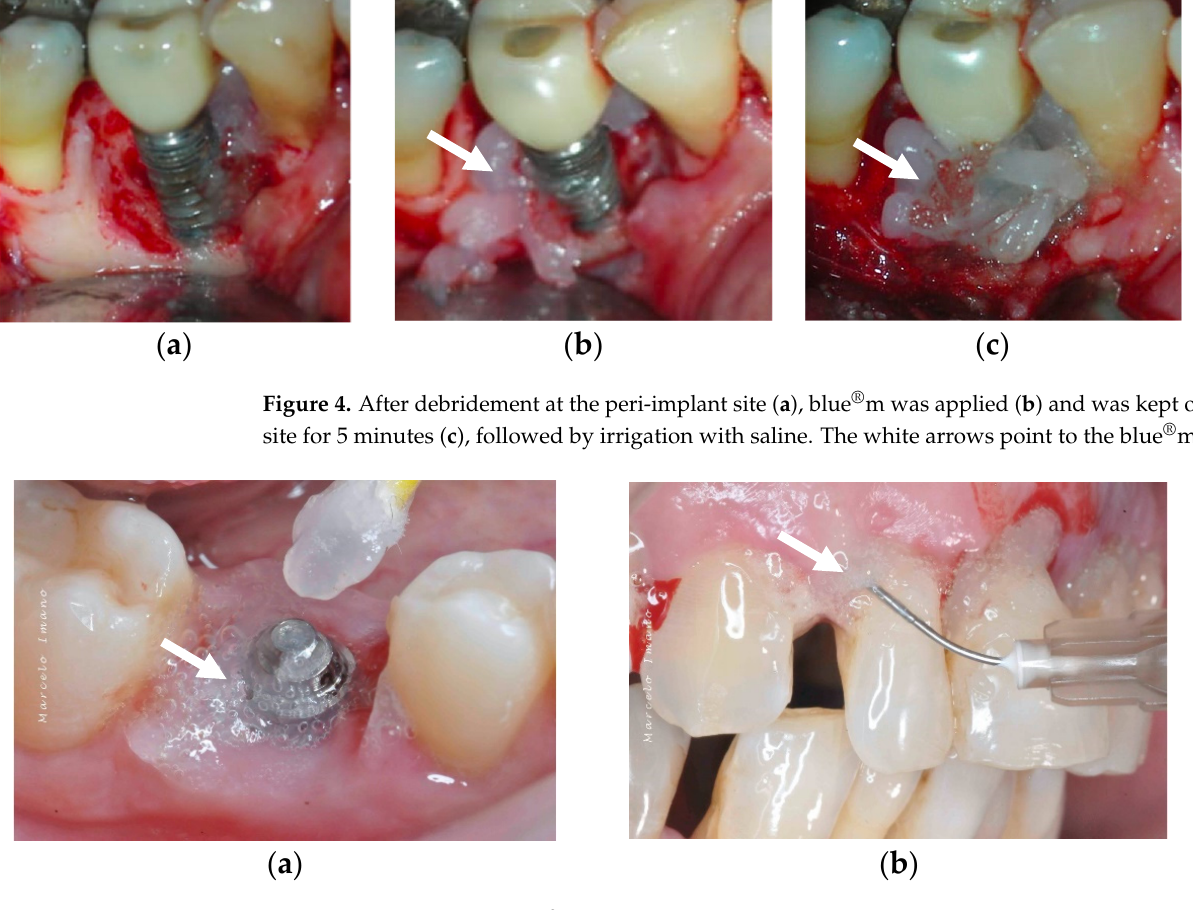
Table 1. Summary of the use of oxygen therapy to induce angiogenesis in oral would healing.